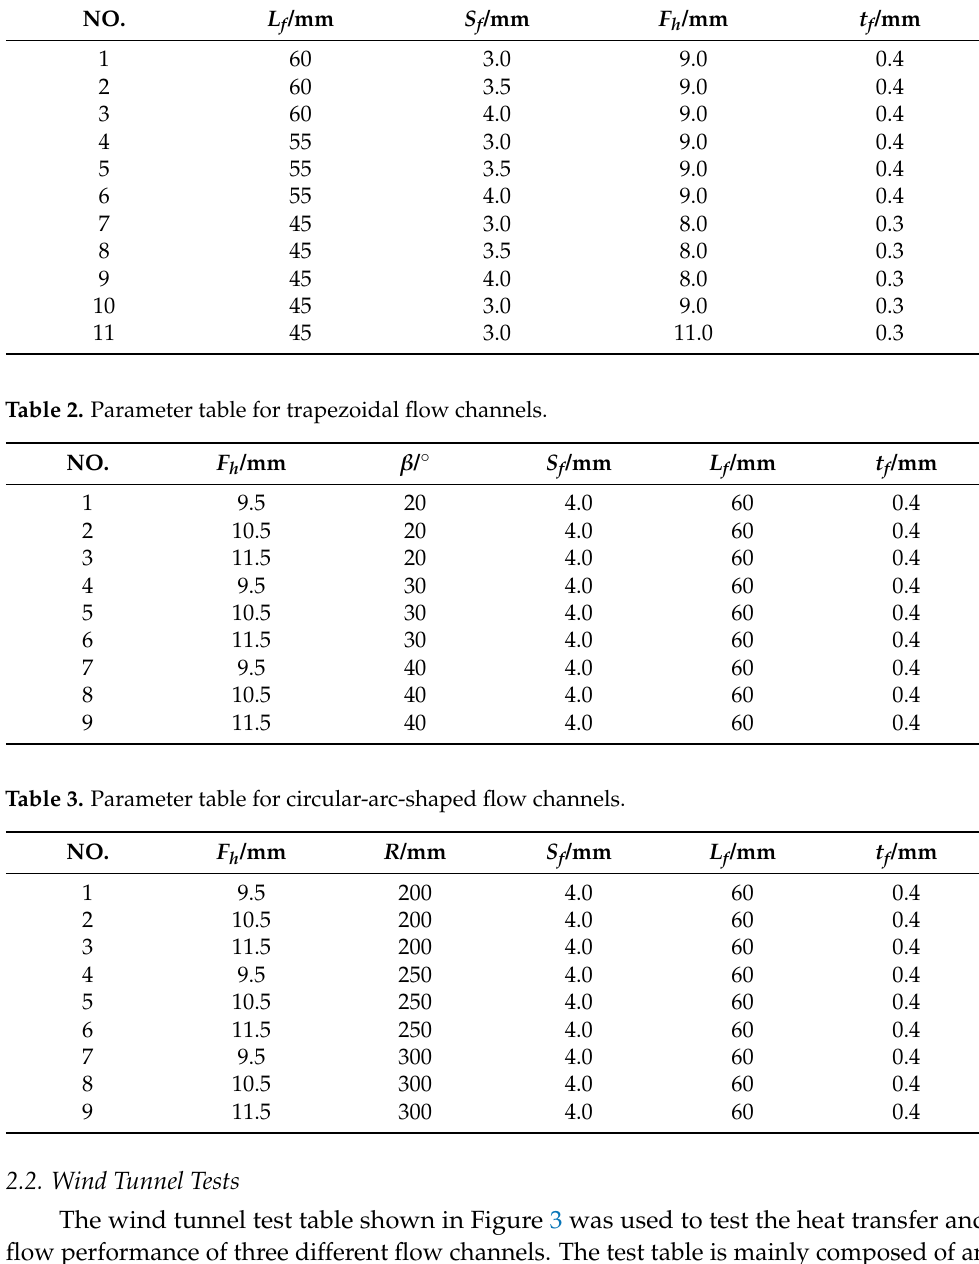
Table 1. Parameter table for equal cross-section flow channels.